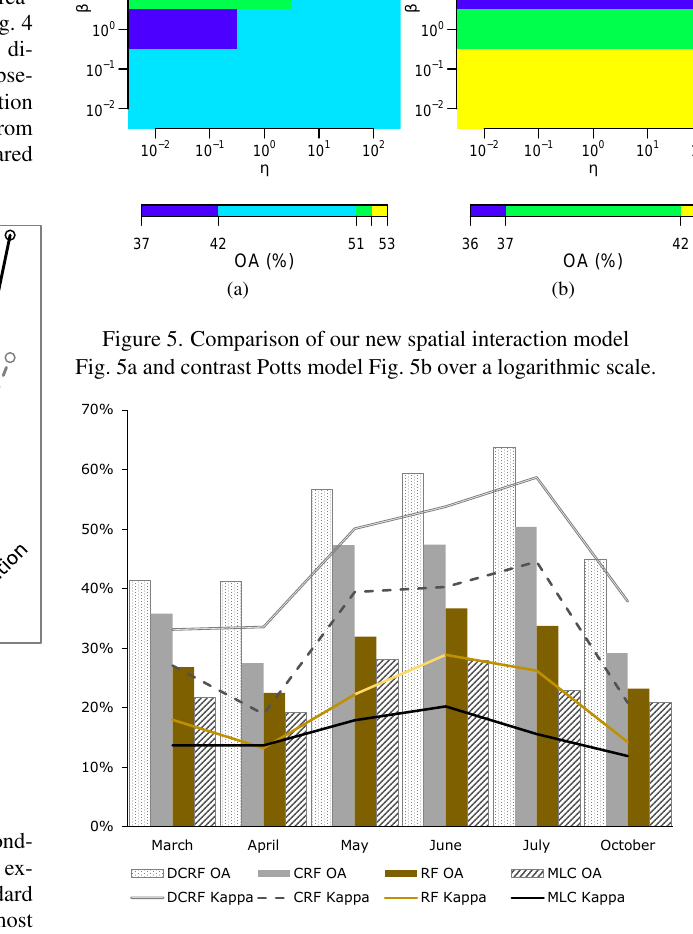
Figure 6. Epoch-wise classification results, overall accuracy and kappa, from different approaches.